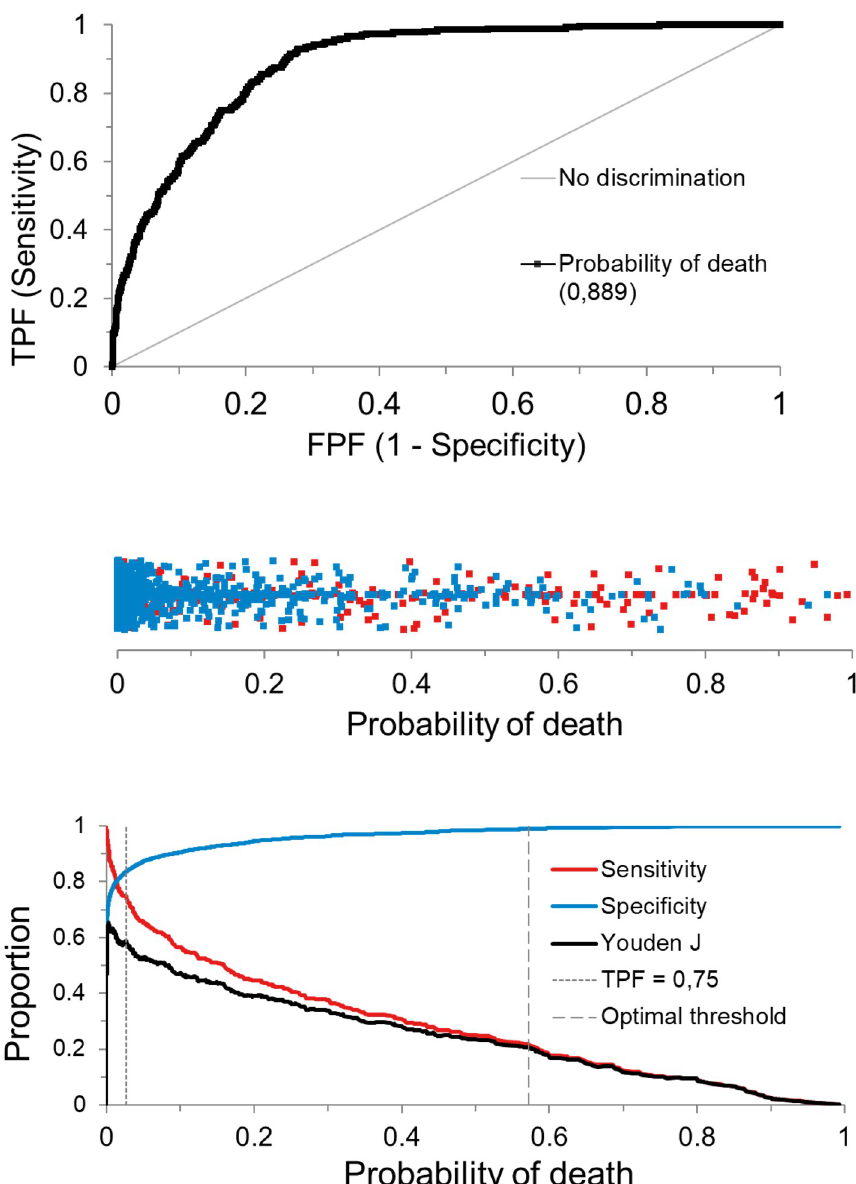
Fig 8. Diagnostic performance of the model including the predictors age, gender and calculated viral load. A) Receiver operating characteristic curve of the model showing an area under the curve of 0.889. B) Scatter plot showing the survivors (blue) and the deceased (red) along with the predicted probability of death calculated by the model. C) the Youden plot highlighting the optimal threshold and the threshold at a fixed sensitivity value of 75%. TPF: True positive fractions (sensitivity). FPF: False positive